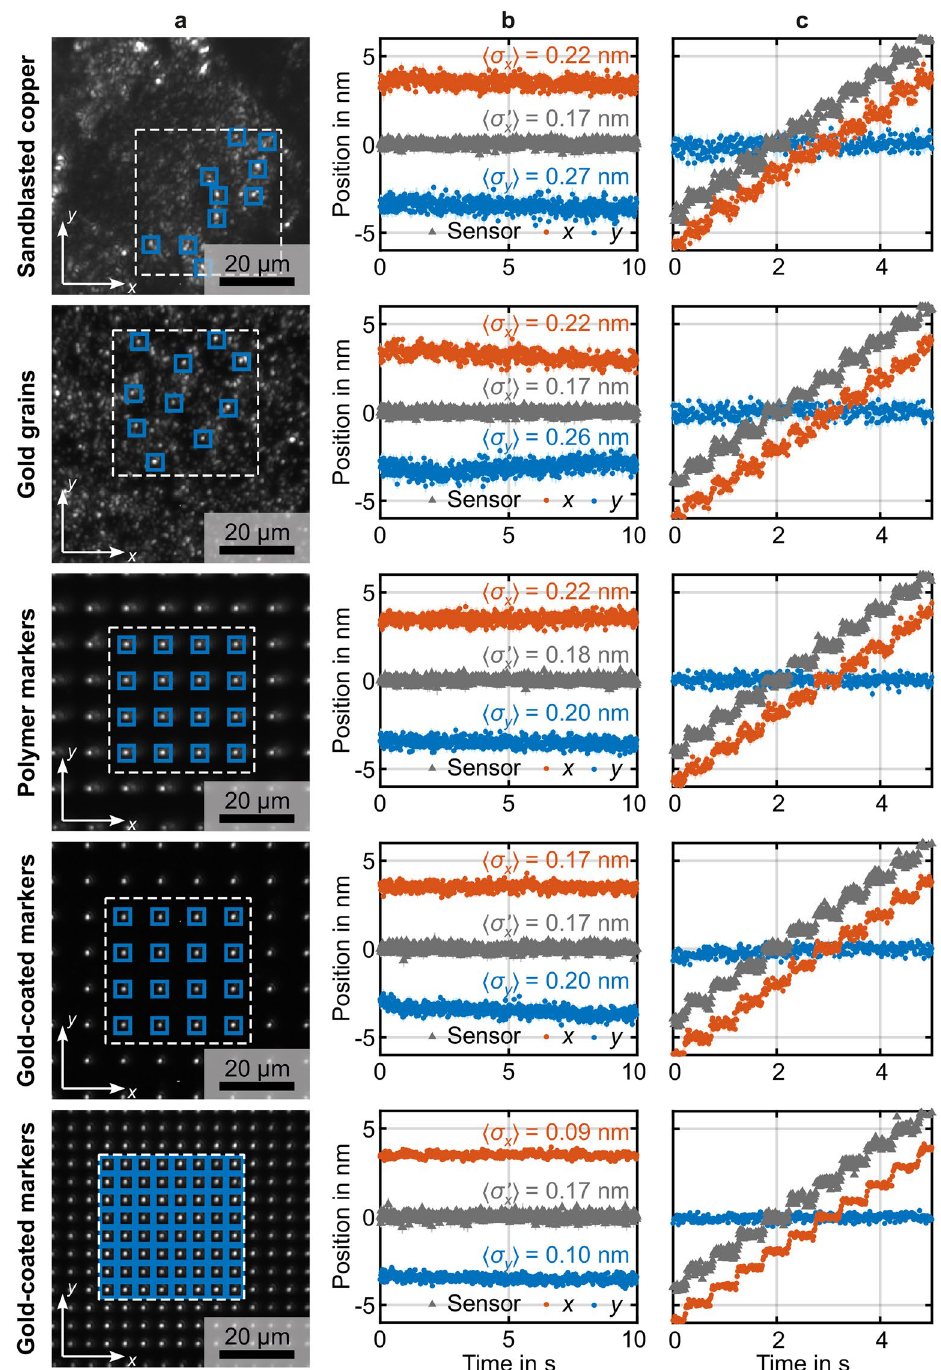
Figure 3. Summary of data obtained from five different samples #1 to #5 (cf. Fig. 2). Column ( a ) exhibits an example optical image with the used regions of interest (ROI) indicated by the blue squares. Each ROI comprises 30 30 camera pixels. The ROI lie in a footprint of ( 40 µ m ) 2 indicated by the dashed white square. Column × ( b ) shows results obtained from the optical-image cross-correlation approach for the x -component (red) and the y -component (blue). For comparison, the read-out signal from the capacitive sensor of the piezoelectric actuator is shown in gray. This signal has been shifted vertically for clarity. For each of the 800 data points, we obtain localization errors σ x and σ y . The mean values the corresponding value for the capacitive sensor, for the same measurement time of 12.5ms . In column ( b ), the piezoelectric actuator has not been moved intentionally. In contrast, in column ( c ), the piezoelectric actuator has been moved in a staircase manner with 1 nm high steps each 0.5s